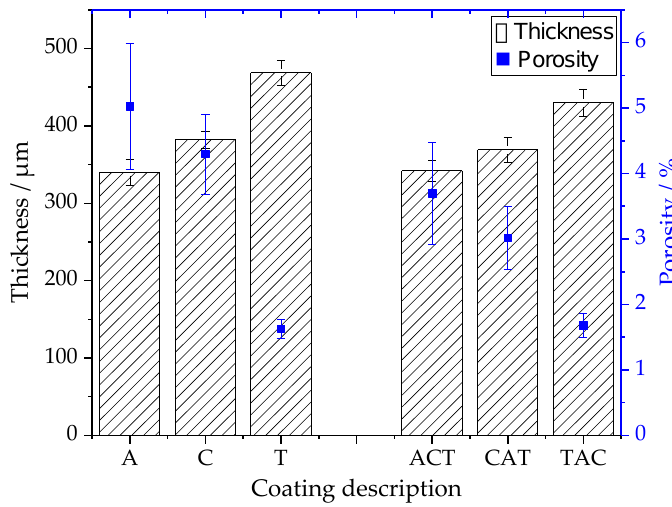
Figure 4. Thickness and porosity of plain oxide coatings (A, C, T) and coatings from blends (ACT, CAT, and TAC).